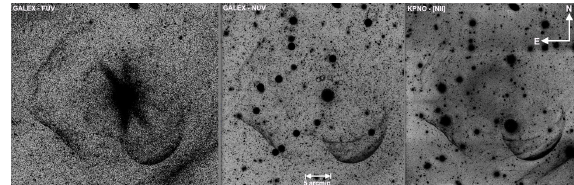
Figure 5: Three images of the classical nova shell sur- rounding the dwarf nova Z Camelopardalis; from left to right they are in Far-UV (1516 ˚A) and Near-UV (2267 ˚A) from GALEX and in [NII] from the KPNO 4m tele- scope. Shell expansion has not yet been detected, but an upper limit of 0.17” per year, corresponding to a ve- locity no greater than 138 km s − 1 has been placed on the expansion of the shell by Shara et al. 2012b. The nova eruption of Z Cam is quite possibly associated with a guest star recorded by Chinese astronomers in 77 B.C. (Johansson 2007). Figure reproduced with permission from Shara et al. 2012b.